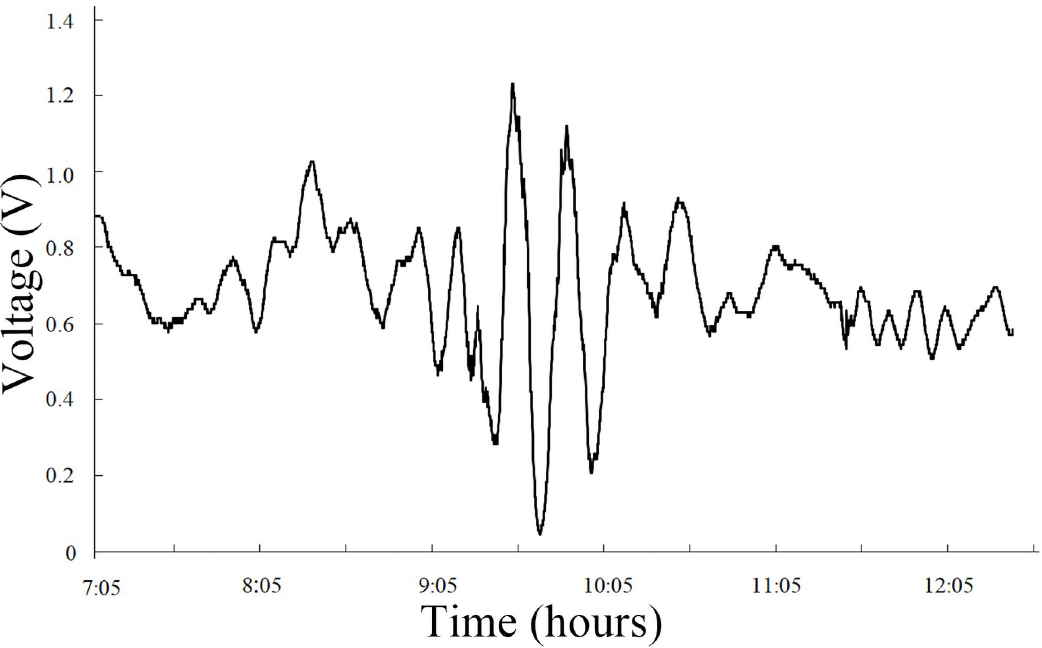
Fig 5. Anomalous infrasound signals on March 29,